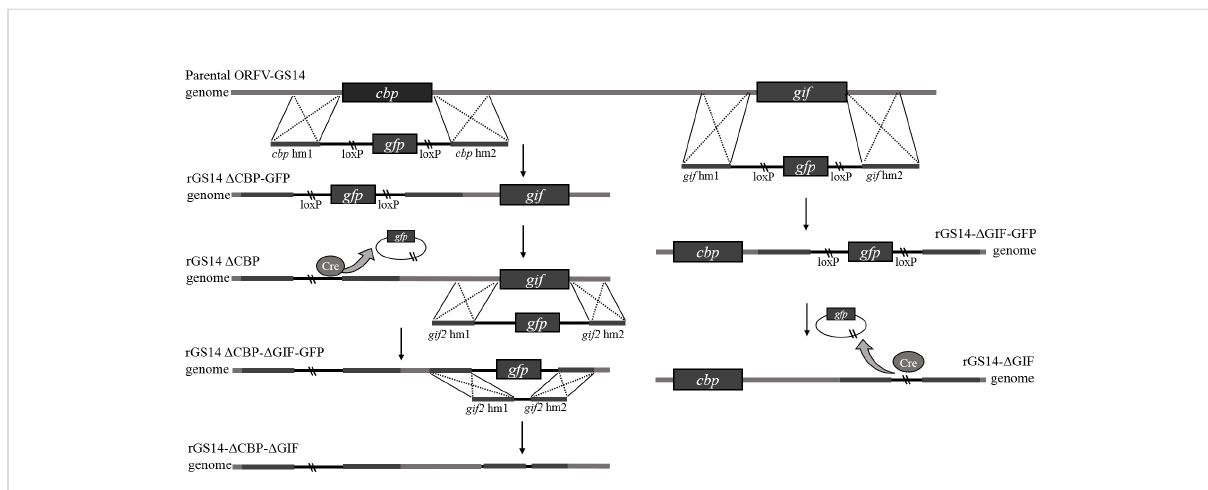
FIGURE 1 Diagram of homologous recombination between plasmid DNA and genome of parental